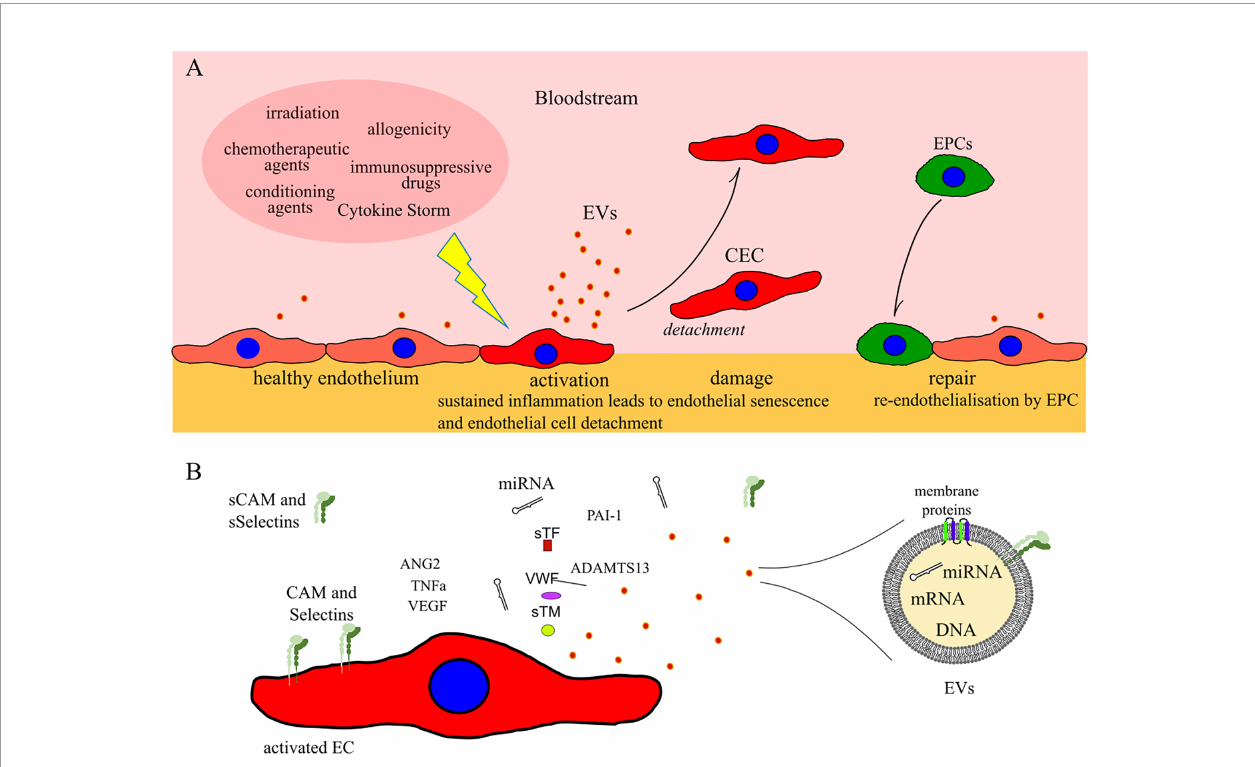
FIGURE 1 | (A) Schematic illustrating ECs activation, damage and repair after allogeneic HCT. (B) Common markers of EC damage which can potentially be used for detection of early post-HCT complications of endothelial origin. CEC: circulating endothelial cells; EPCs: progenitor endothelial cells; EVs: extracellular vesicles; CAM and sCAM: cell adhesion molecules and soluble CAM; sSelectins: soluble